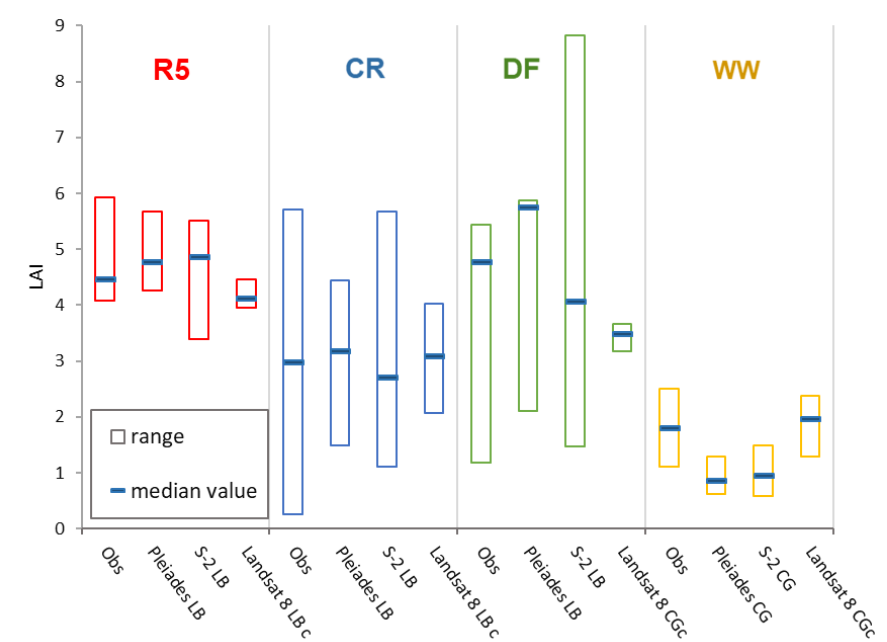
Figure 5. Ranges and median values of observed LAI (Obs) and LAI retrieved from remote sensing imagery in the Cammarota reaches.